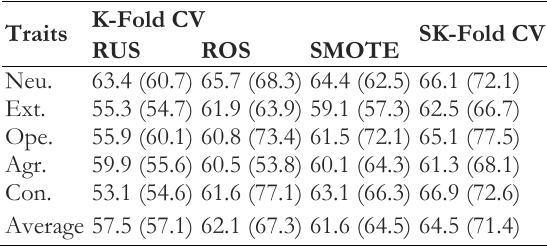
Fig. 8. Training and development loss error diagrams for conscientiousness trait classification in the SPC dataset evaluated by the S10-Fold CV method. Table 3. Comparison of personality classification by K-Fold CV and SK-Fold CV methods in SPC dataset.